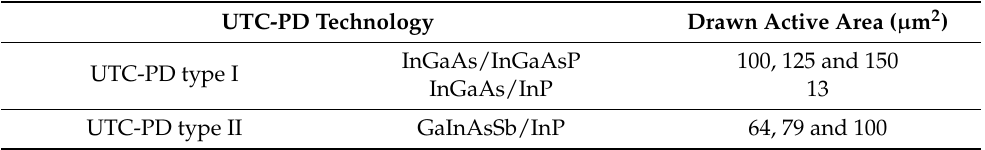
Table 1. Geometries of the UTC-PDs under study.